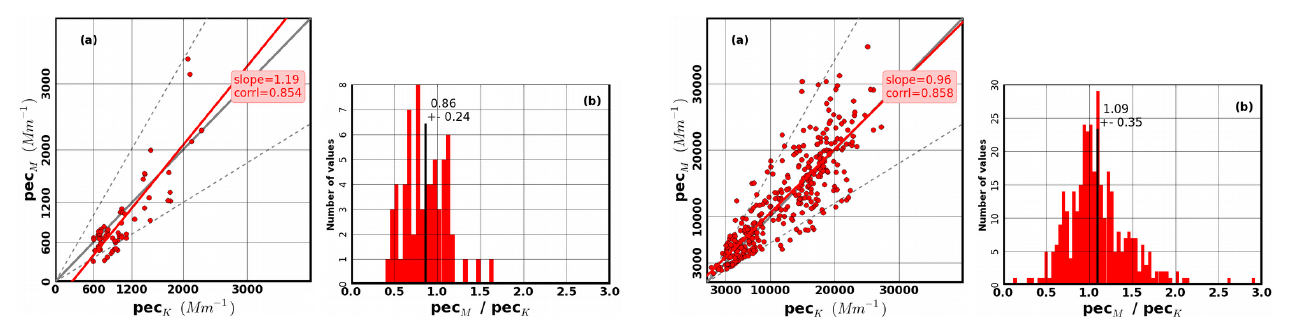
Figure 6. As in Fig. 5 but for the fog regime. The size distribution is generated by combining WELAS and FM100, and two values of the refractive index are used (see